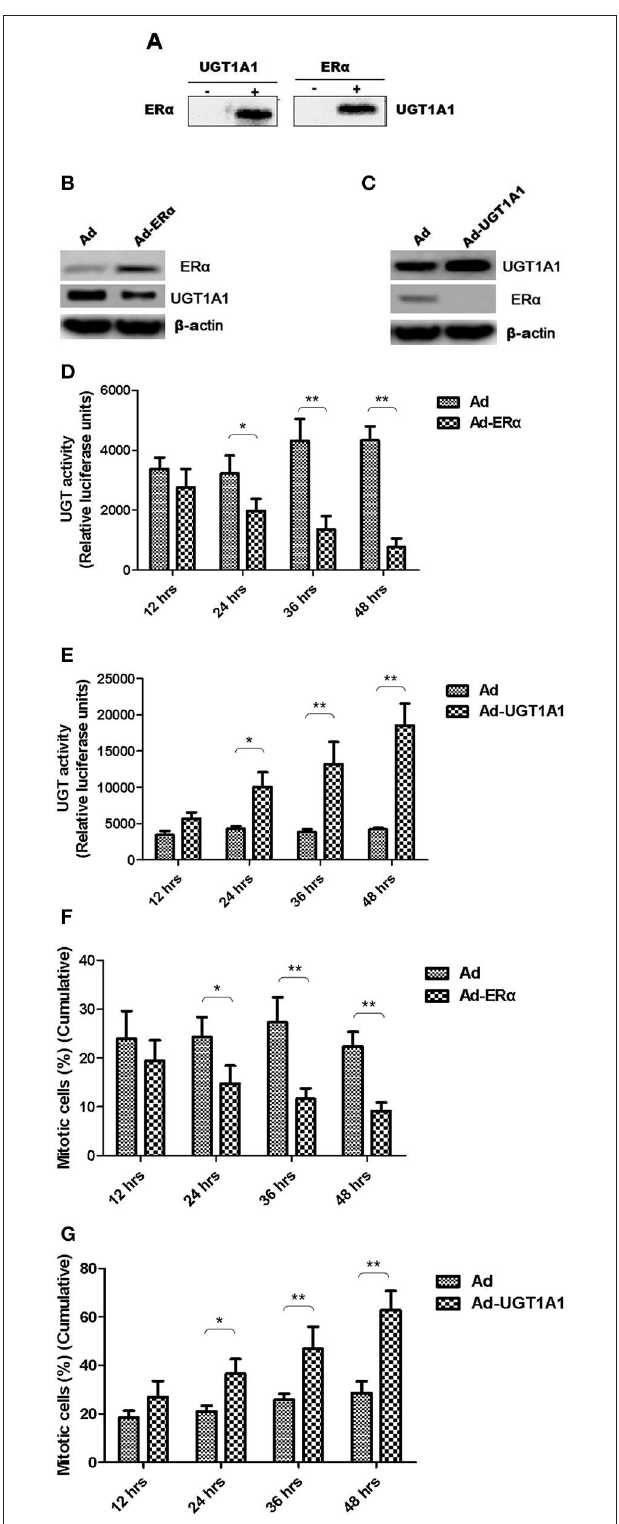
FIGURE 5 | The interaction between UGT1A1 and ER α in TNBC cells. Moreover, the CO-IP assay was conducted to verify the interaction